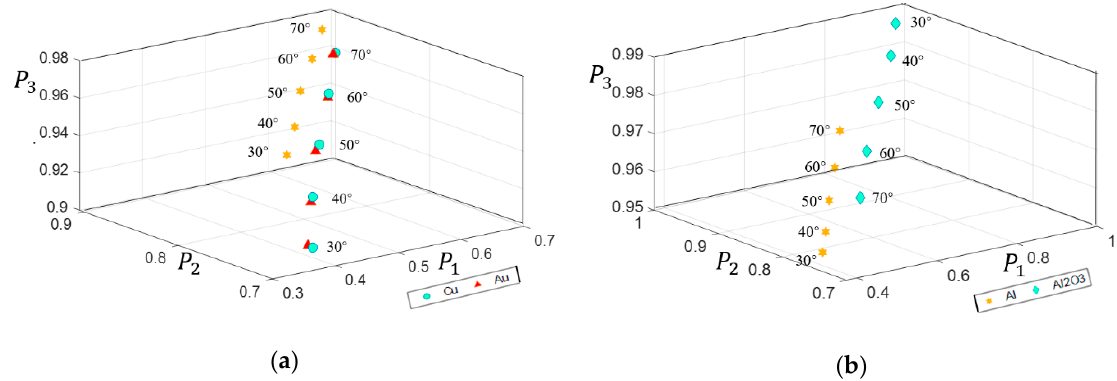
Figure 7. The overall distributions of P 1 , P 2 , P 3 corresponding to different incident angles: ( a ) samples as Cu, Au, Al; ( b ) samples as Al, Al 2 O 3.